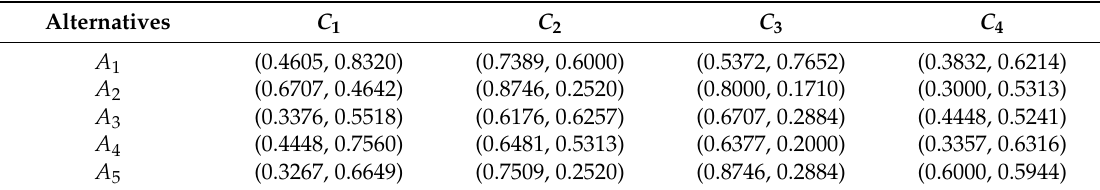
Table 5. The collective decision matrix obtained by the PFDWMM operator.